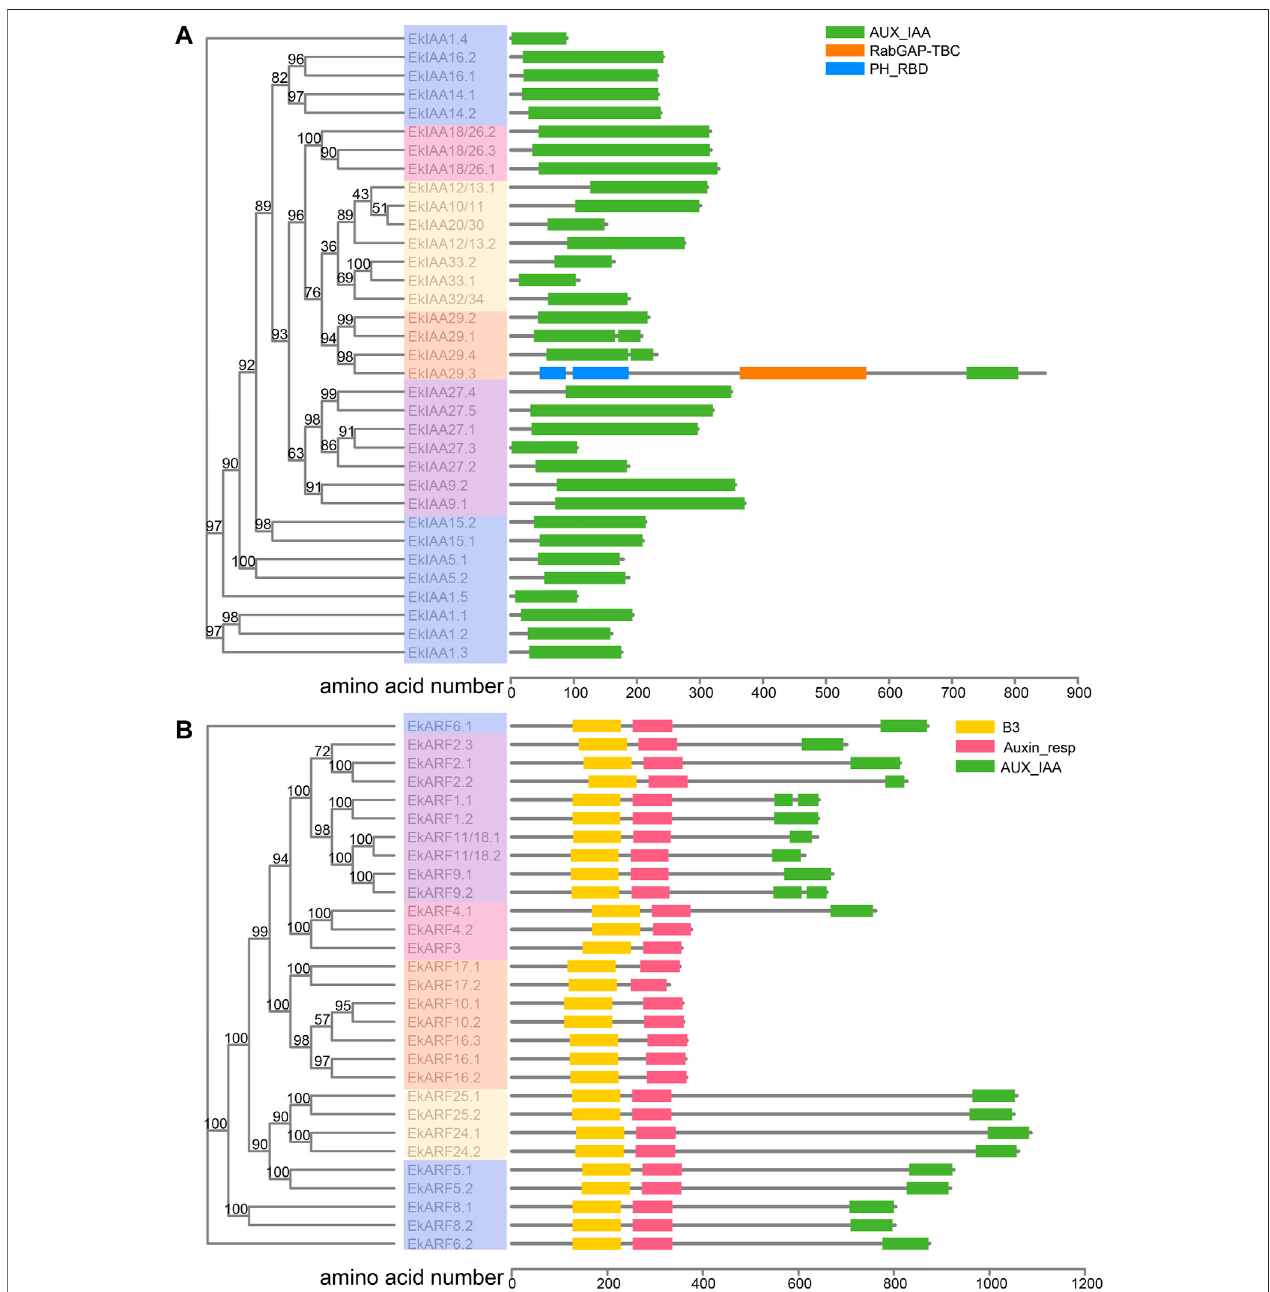
FIGURE1| Phylogeneticrelationshipsandproteindomain mapsof E.konishii IAA (A) andARF (B) proteins. Left,phylogeneticrelationshipof34 IAAs and29 ARFs from E. konishii . Different colors represent different groups. Right, IAA and ARF protein domain composition. Bootstrap values are shown close to branch nodes.